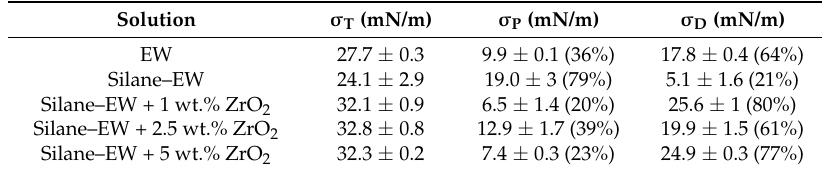
Table 1. Surface tension ( σ T ), polar ( σ P ), and dispersive ( σ D ) components of the ethanol/water (EW) and its combinations with silanes and ZrO 2 .